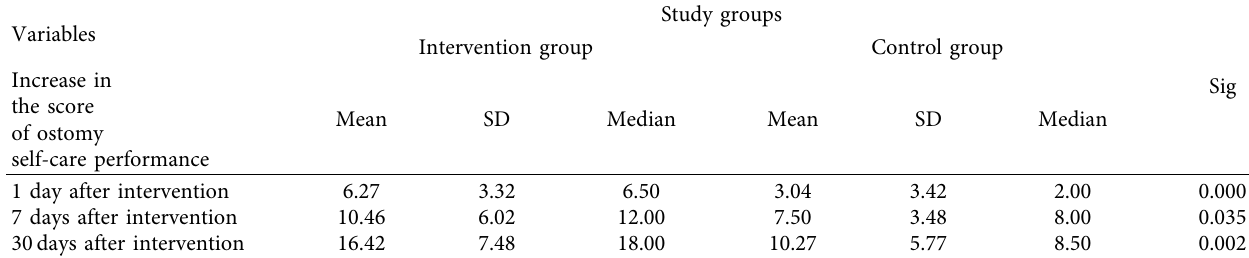
Table 2: Comparison of the increase in the score of ostomy self-care performance in the two groups of the study. Study groups Variables SigIntervention group Control group